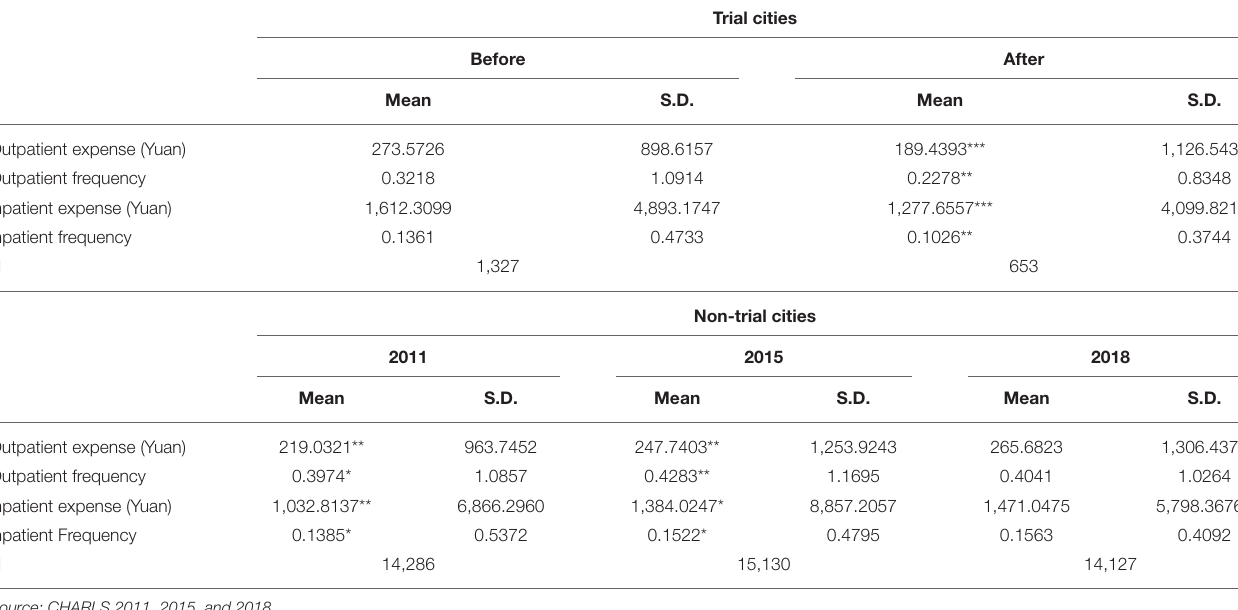
TABLE 2 | The comparison of medical service utilization, 2011, 2015, and 2018.